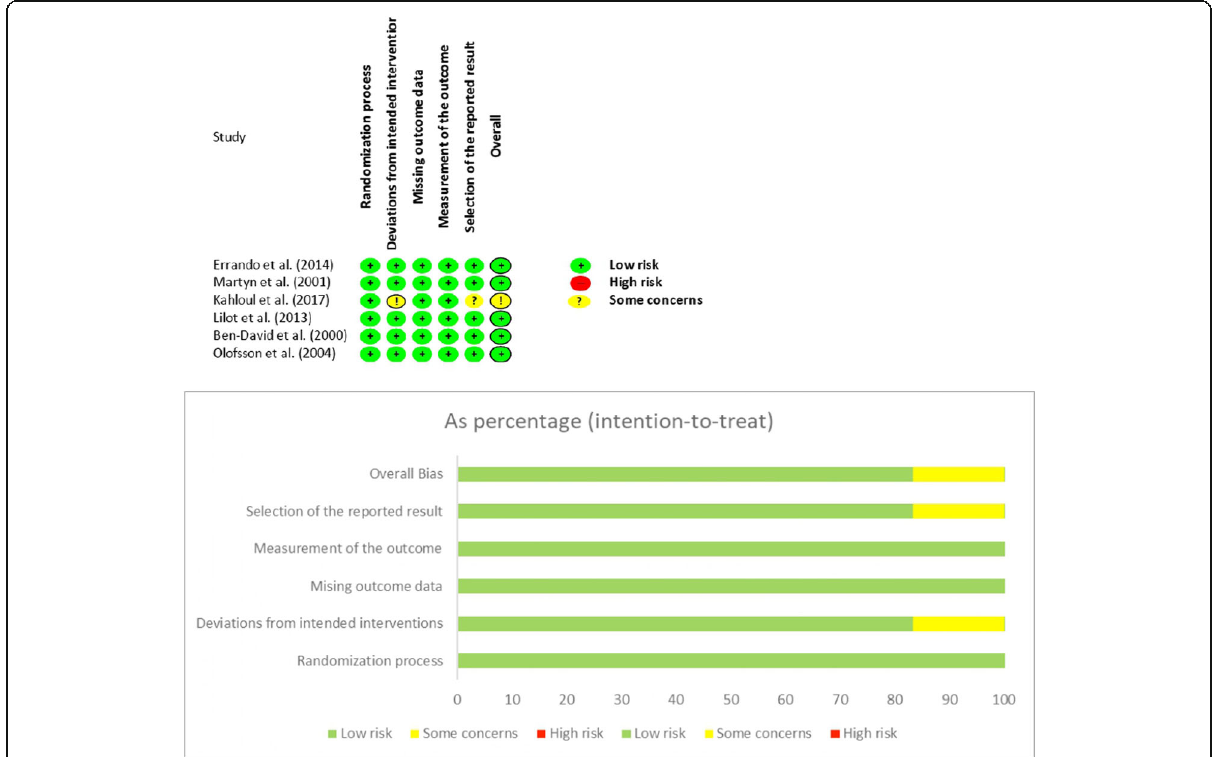
Fig. 2 Cochrane Collaboration ’ s Risk of Bias assessment and summary (RoB-2 version 2019) [27]. Green circles = low bias; yellow circles = some